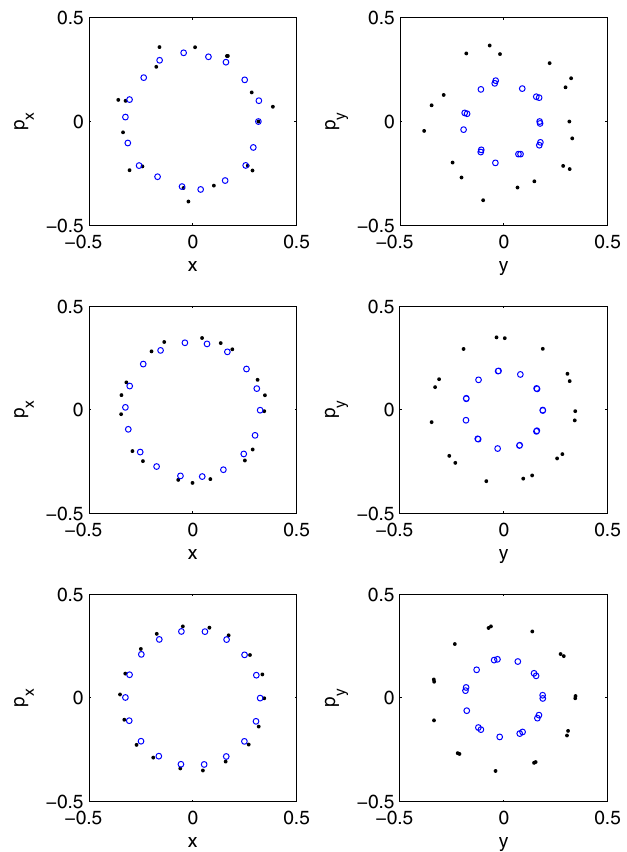
FIG. 1. (Color) Nonlinear decoupling. Top: nonlinear map. Middle: map normalized using second-order turn-independent canonical transformation. Bottom: map further normalized using third-order turn-dependent canonical transformation. The solid black points show the result of mapping with initial values for (cid:1) 0 : 05 , J (cid:1) 0 : 05 ; the open blue circles show the the actions J x y results of mapping with initial values for the actions J (cid:1) 0 : 015 J y